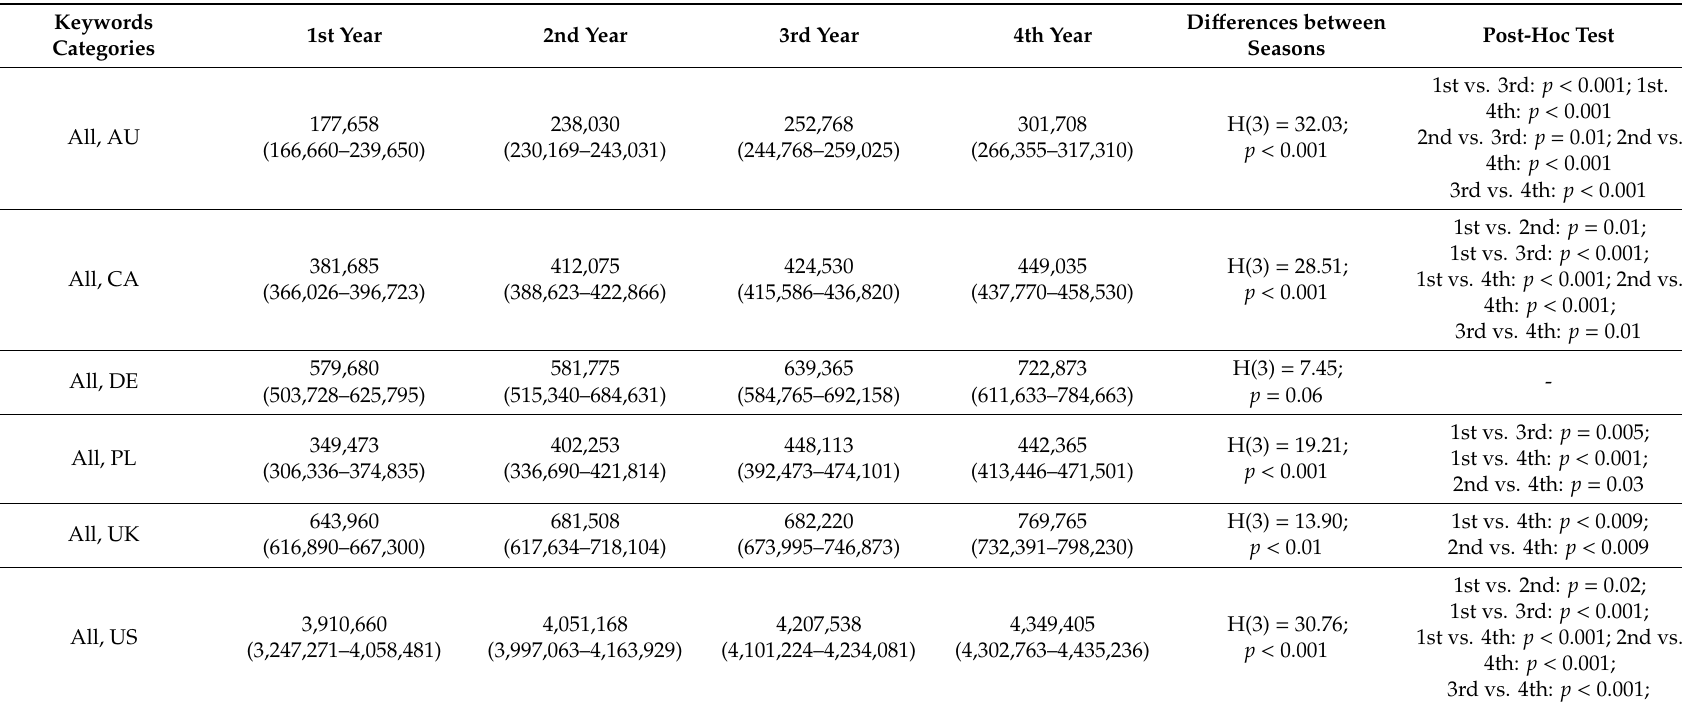
Table 3. Comparison of heartburn-related searches per month for each